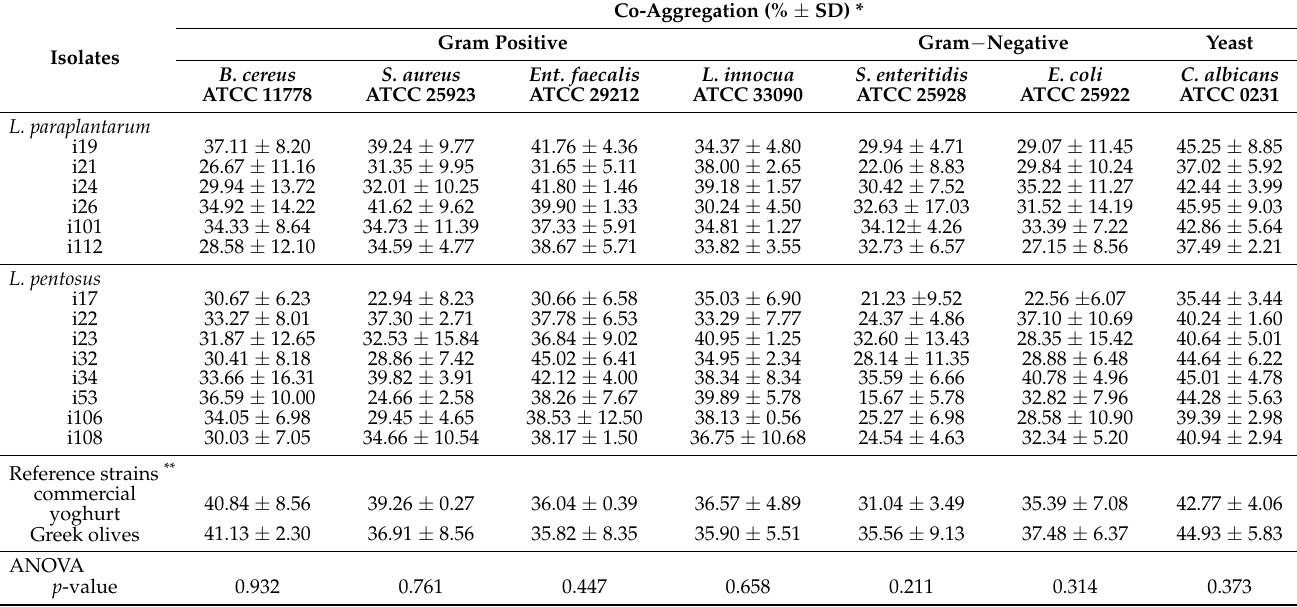
Table 3. Performance of L. pentosus and L. paraplantarum strains pertaining to co-aggregation with